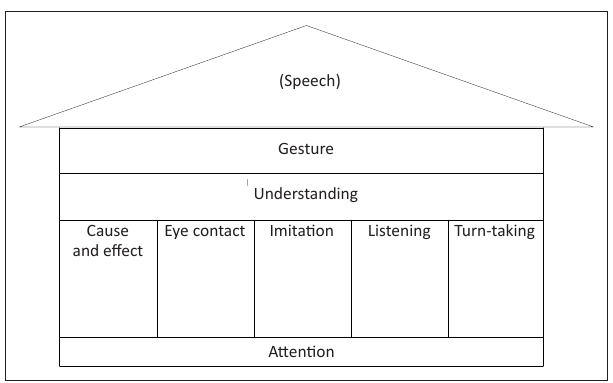
FIGURE 1: ‘The Communication House’ adapted from Let’s communicate (WHO 1997).